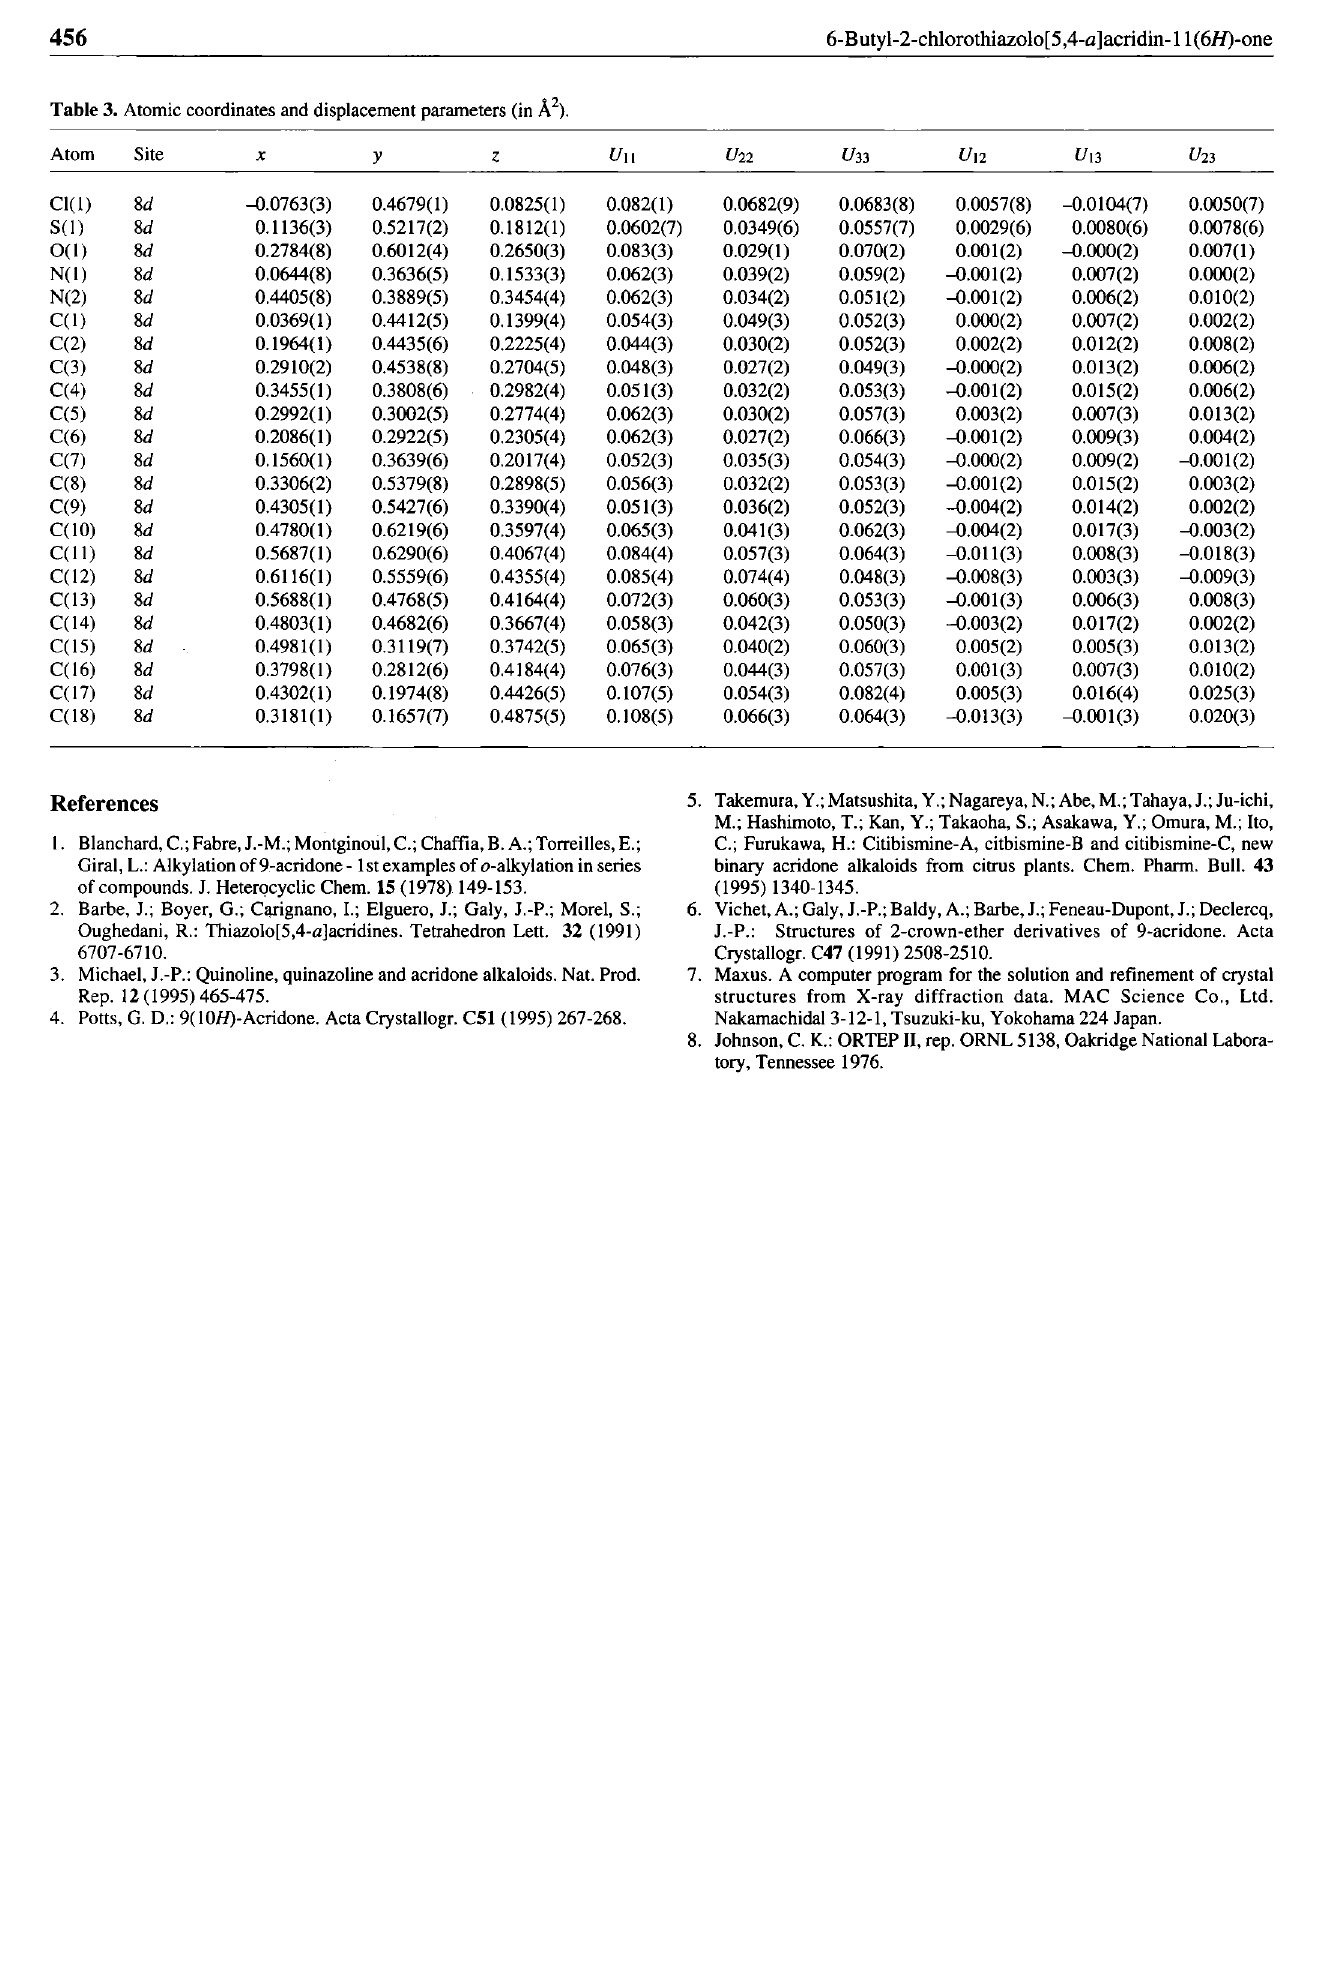
Table 3. Atomic coordinates and displacement parameters (in Ä 2